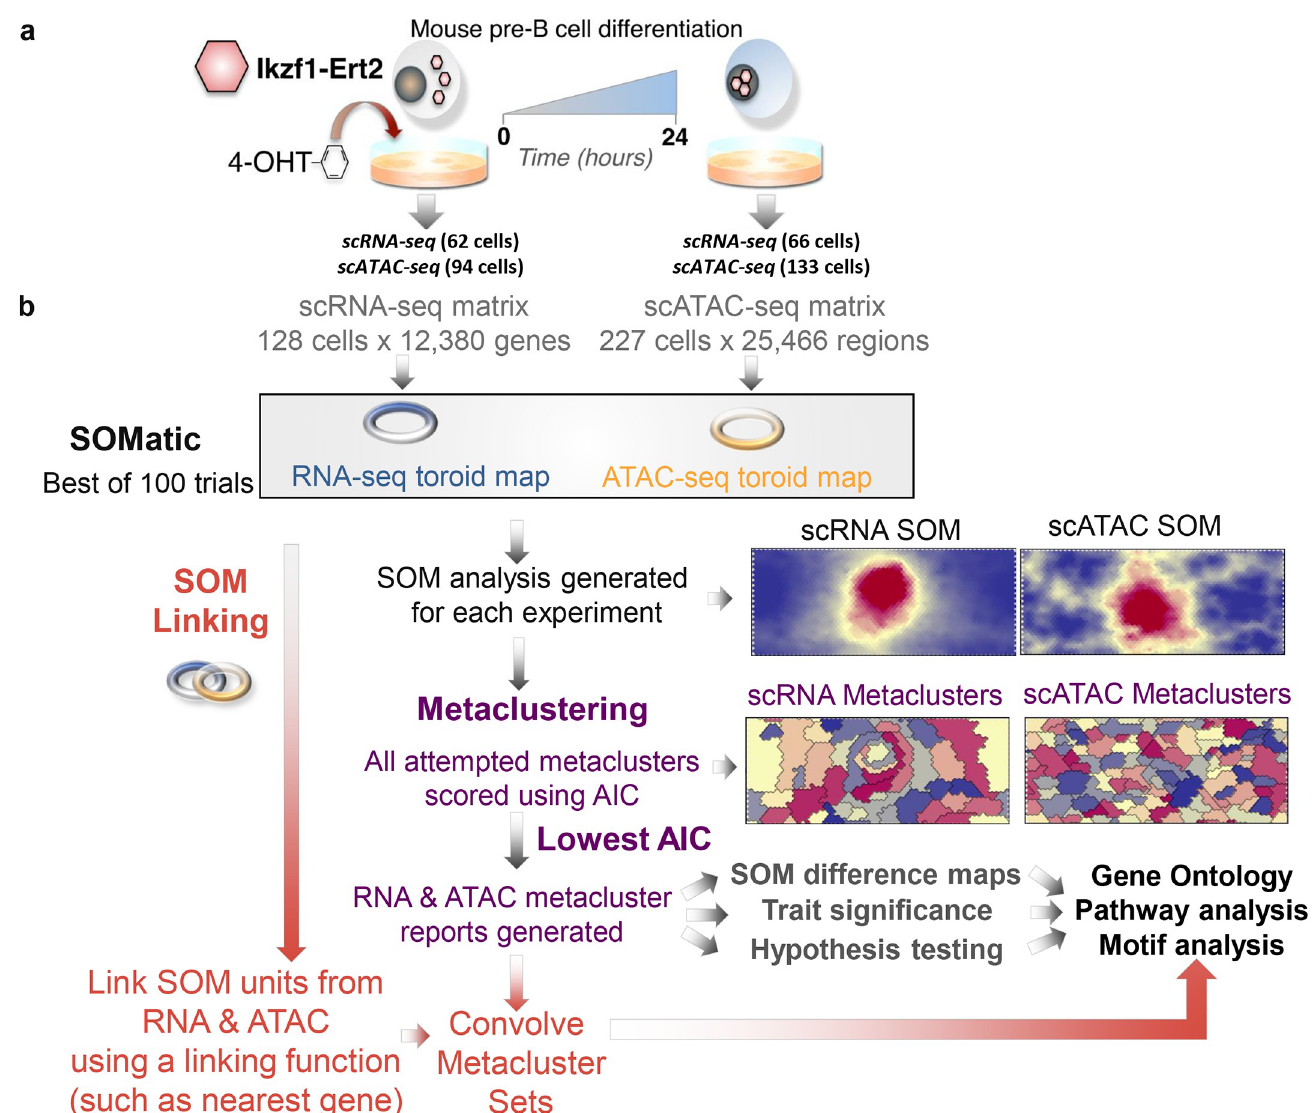
Fig 1. Single–cell multi–data integration using SOMs. (A) An inducible Ikaros mouse pre–B cell–line was used to track changes in gene expression and chromatin accessibility during differentiation (0 and 24–hours) in single–cells. (B) Single–cell RNA–seq and ATAC–seq data from an inducible mouse pre–B cell– line were independently trained using SOMatic to generate single–cell SOMs and metaclustered using AIC scoring. These clusters were convolved with the new SOM linking algorithm to generate pair–wise metaclusters of chromatin regions with similar profiles across the single–cell dataset that regulate genes that also share similar profiles. These pair–wise clusters were mined for regulatory connections through motif enrichment